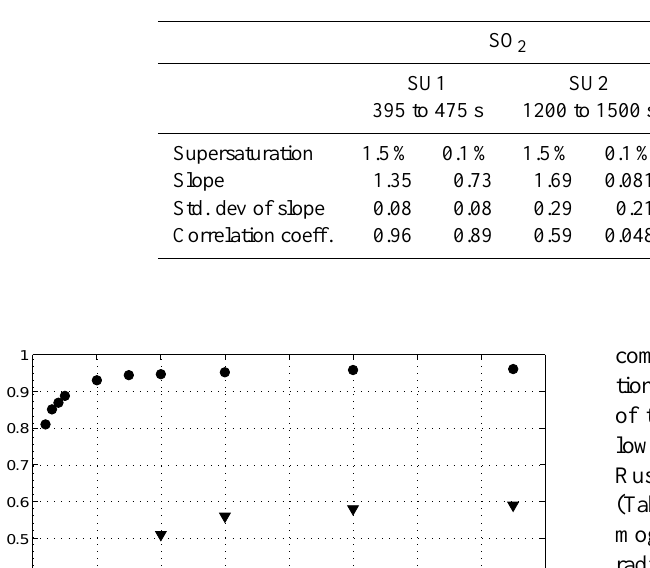
Table 4. Linear regressions of CCN (#cm − 3 ) on SO 2 (pptv) or CN (#cm − 3 ) for two CBL events. SU1: Period 395 to 475s for a pollution event ( n = 24). SU2: Period 1200 to 1500 s in the absence of pollution ( n = 65).